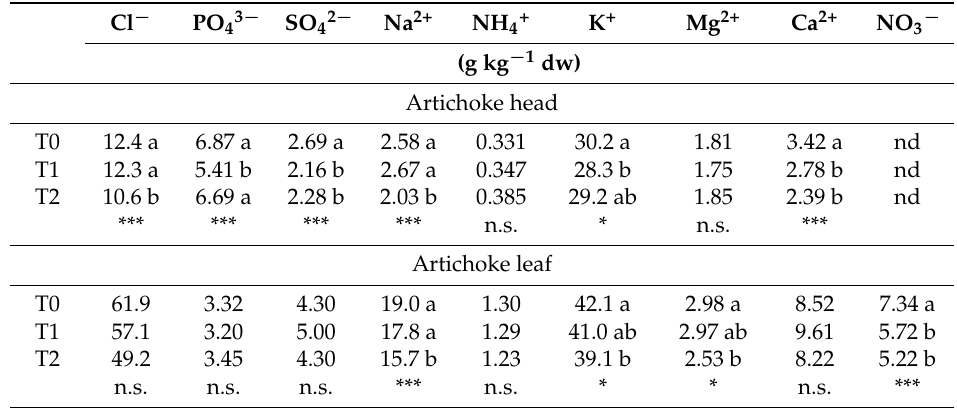
Table 7. Effect of cuttings type used for the vegetative propagation on mineral content in artichoke head and leaves.